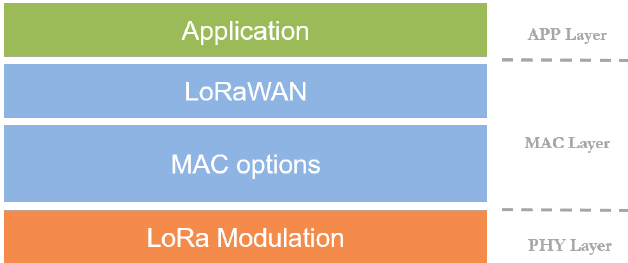
Figure 2. LoRaWAN (Long Range Wide Area Network)